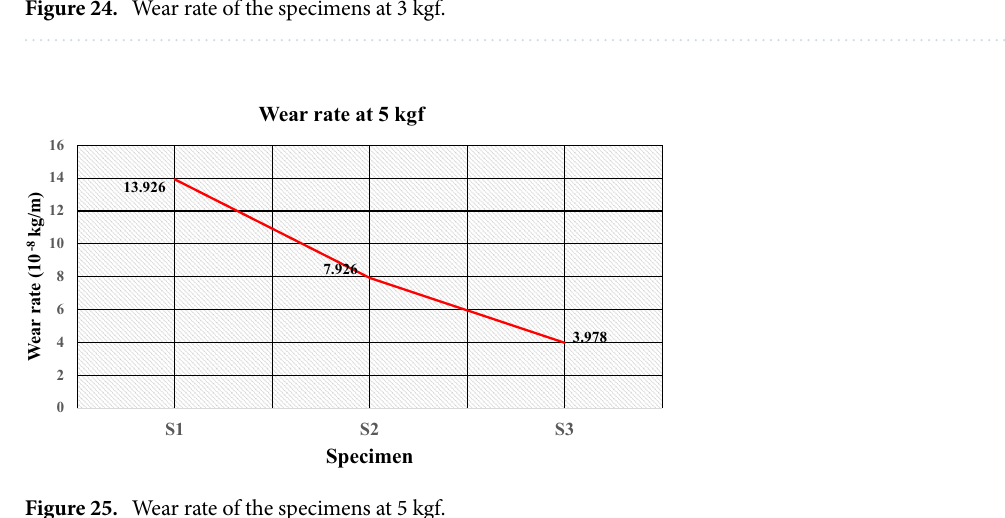
Figure 24. Wear rate of the specimens at 3 kgf.